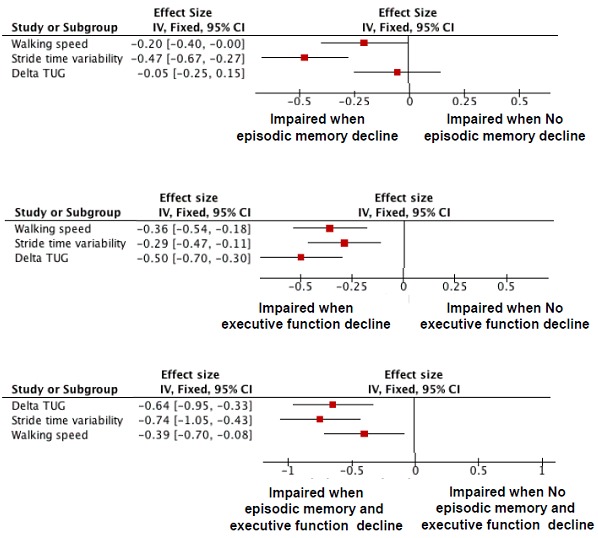
Effect size of the association of gait speed, stride time variability, and delta time of Timed up & Go with lower cognitive performance in memory and executive domains (n = 934).TUG: Timed up & Go; delta time of Timed up & Go calculated from the formula: (Timed up & Go realized – Timed up & Go imagined/((Timed up & Go realized – Timed up & Go imagined)/2) ×100.